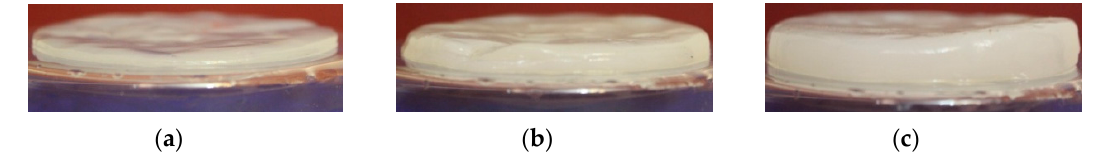
Figure 2. SEM images of freeze-dried BC harvested after ( a ) two days, ( b ) four days, ( c ) six days and ( d ) 10 days (magnification: 50,000 × ).